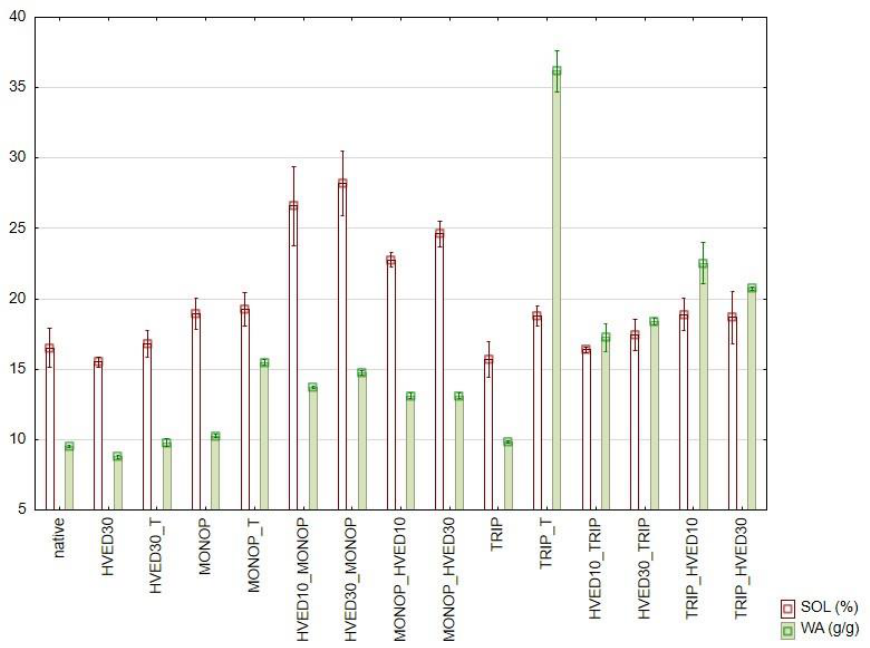
Figure 1. Solubility (SOL) and water absorption (WA) of native and modified maize starches (HVED10 = 10 min treatment with HVED; HVED30 = 30 min treatment with HVED; MONOP = Na 2 HPO 4 ; TRIP = Na 5 P 3 O 10 ; T = thermal treatment).